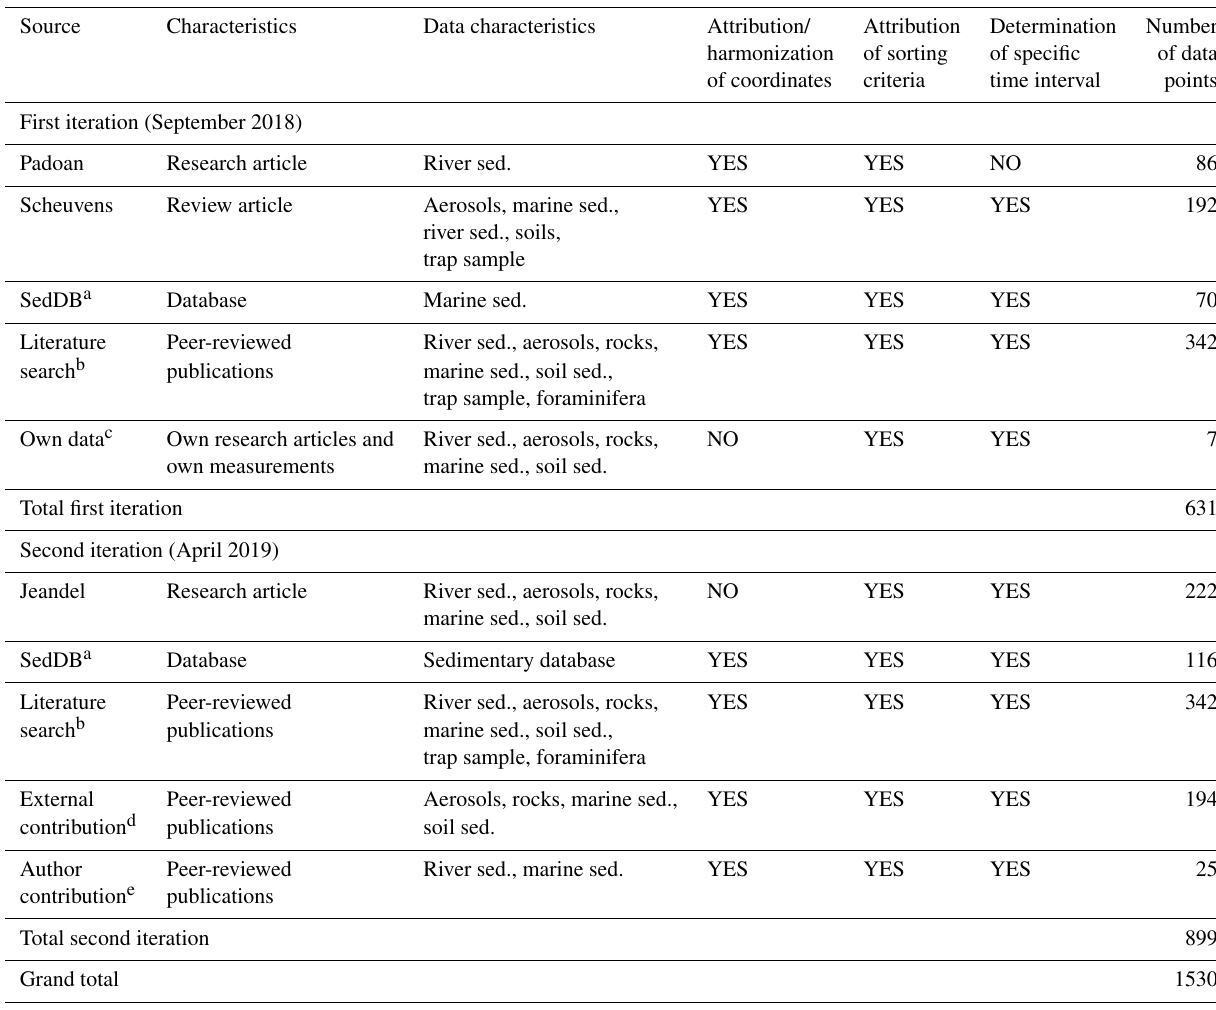
Table 1. Data input sources and type of data provided in two iterations of the database (September 2018 and April 2019). The first column shows the input sources (Padoan et al., 2011; Scheuvens et al.,